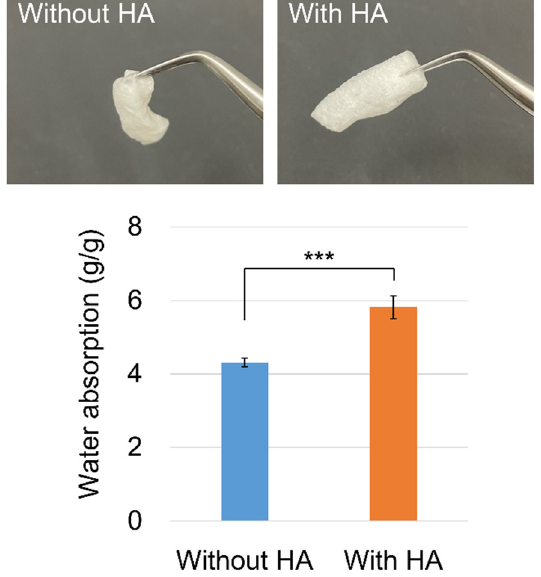
Figure 4. Swelling degree of PAA/PVP complexes with or without HA after being soaked in water for 10 s. Data were expressed as the weight ratio of absorbed water to the total weight of the polymers. Significance in difference between two groups was tested using Student’s t -test. (mean ± SD, *** p < 0.001).